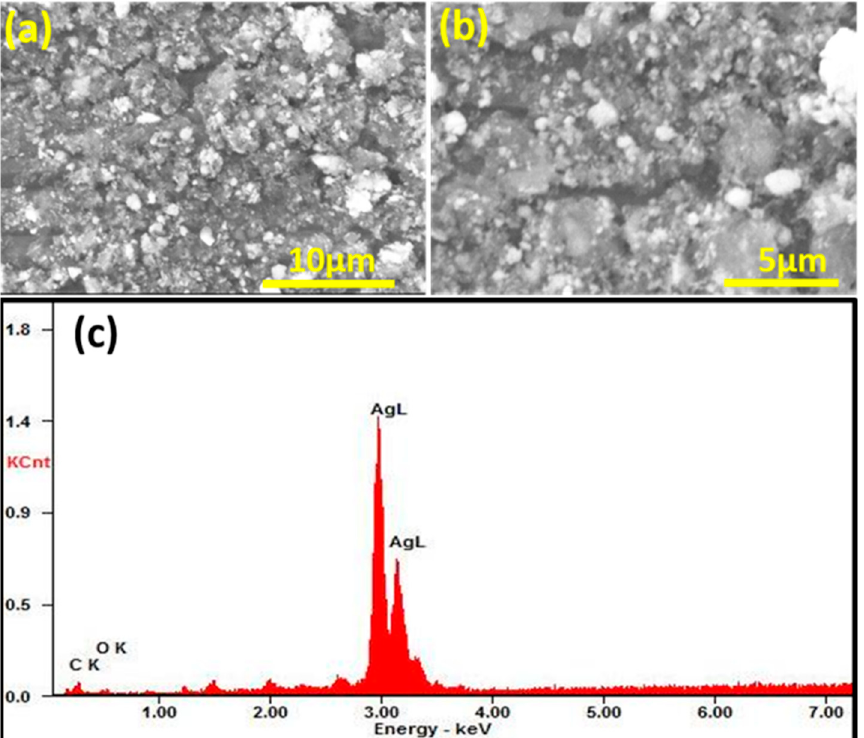
Figure 2. ( a , b ) SEM images of Artemisia vulgaris -mediated AgNPs at different magnification and ( c ) EDX spectrum of Artemisia vulgaris -mediated AgNPs.